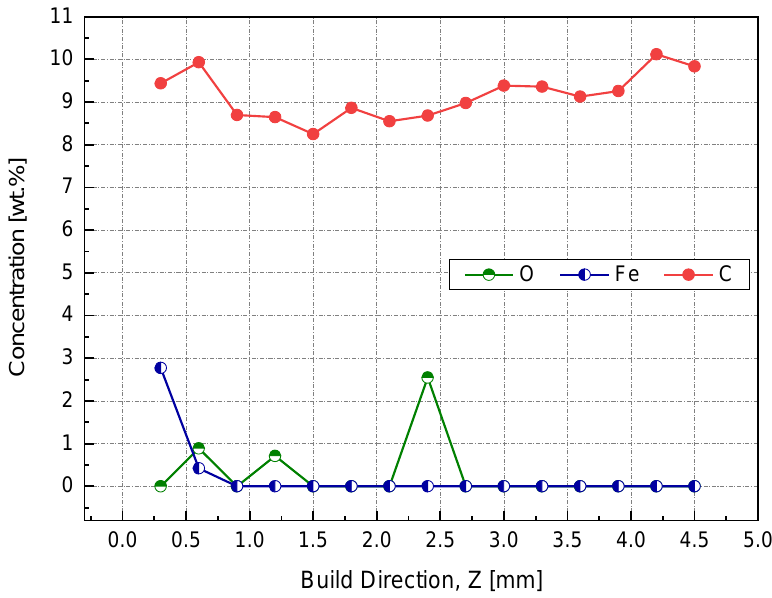
Figure 19. Weight percent of impurities across the height of the Cu sample manufactured by L-PBF, as identified by EDX.